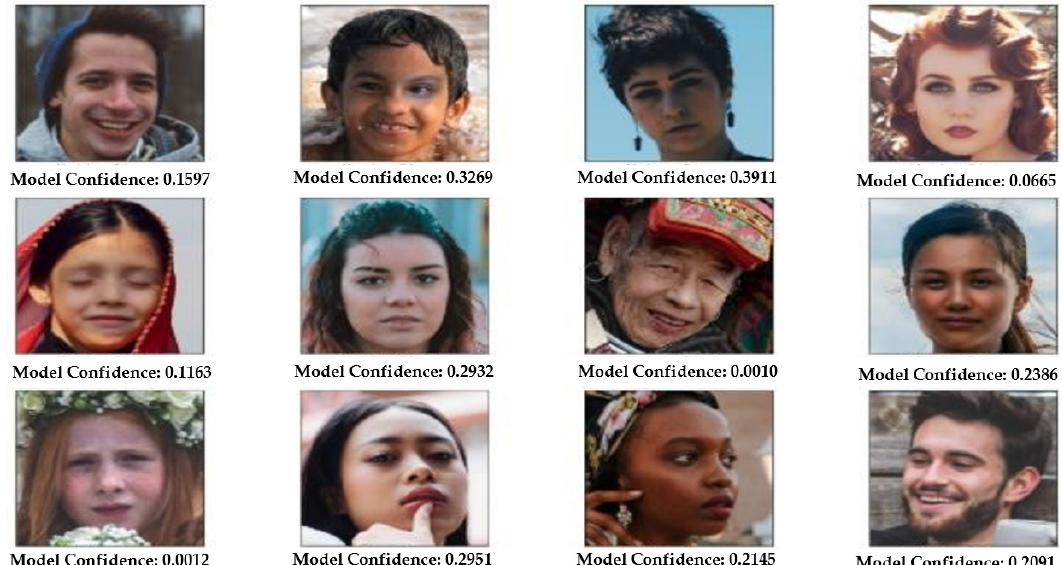
Figure 7. Correct DeepFake prediction: showing the model confidence in the prediction.